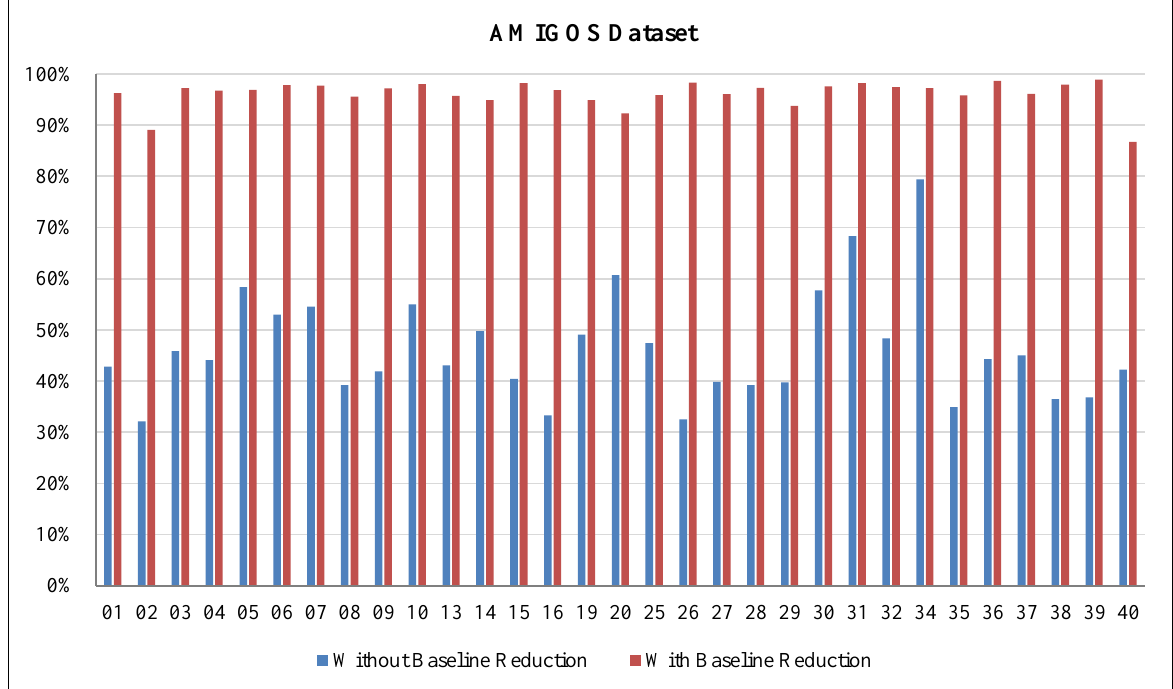
Figure 11. Comparison accuracy with and without baseline reduction approach on the AMIGOS dataset